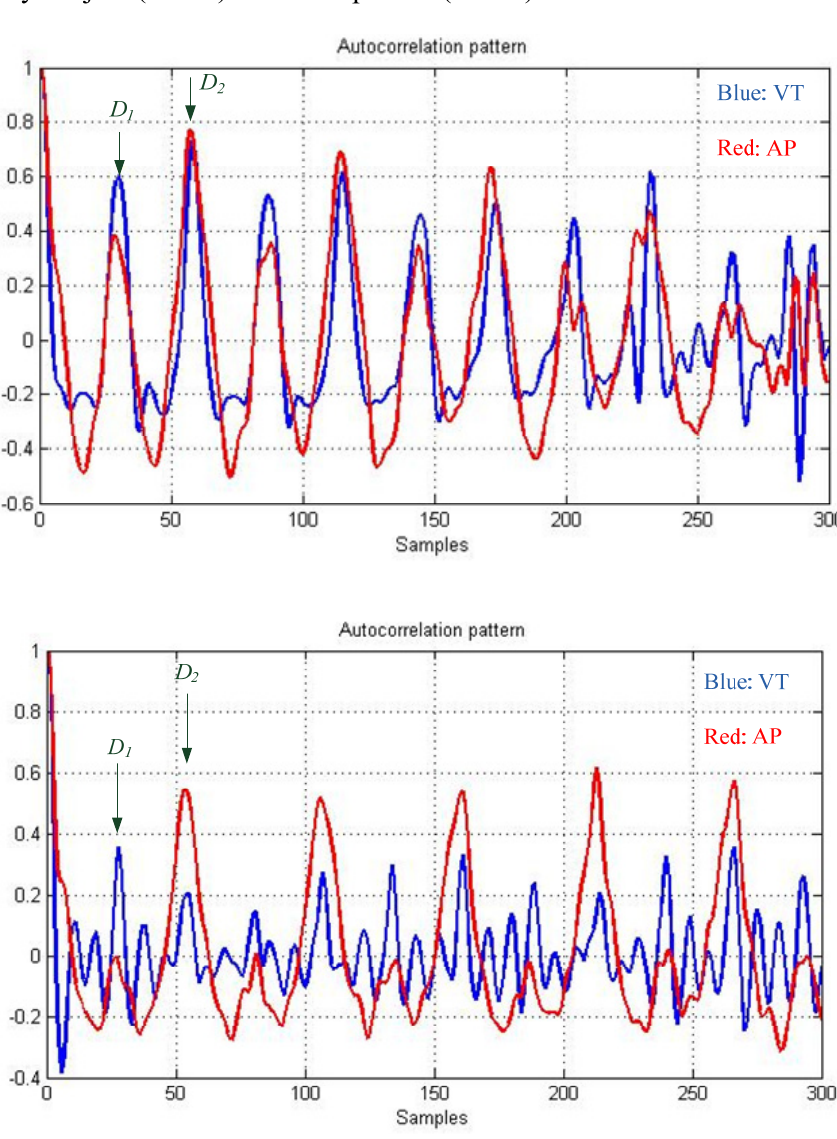
Figure 4. The example of the VT and AP autocorrelation sequences computed from a young healthy subject (above) and a PD patient